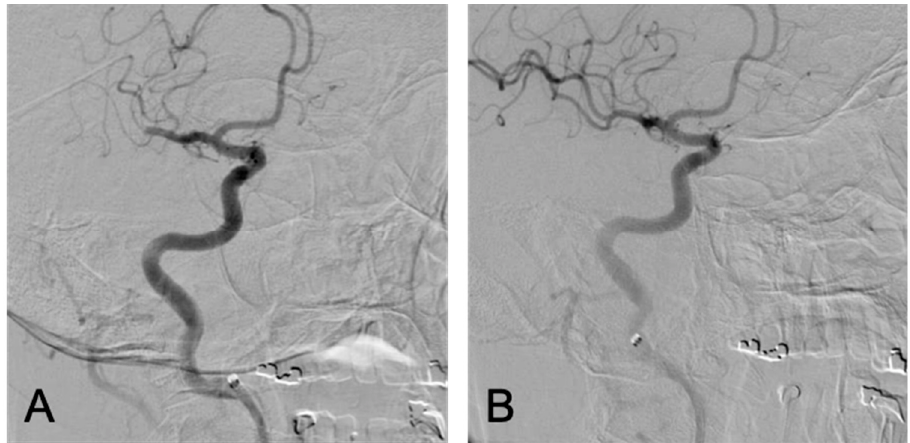
Figure 4. Third Thrombectomy, PA views: right M2 dominant inferior division occlusion before ( A ) and after ( B ) successful thrombectomy.